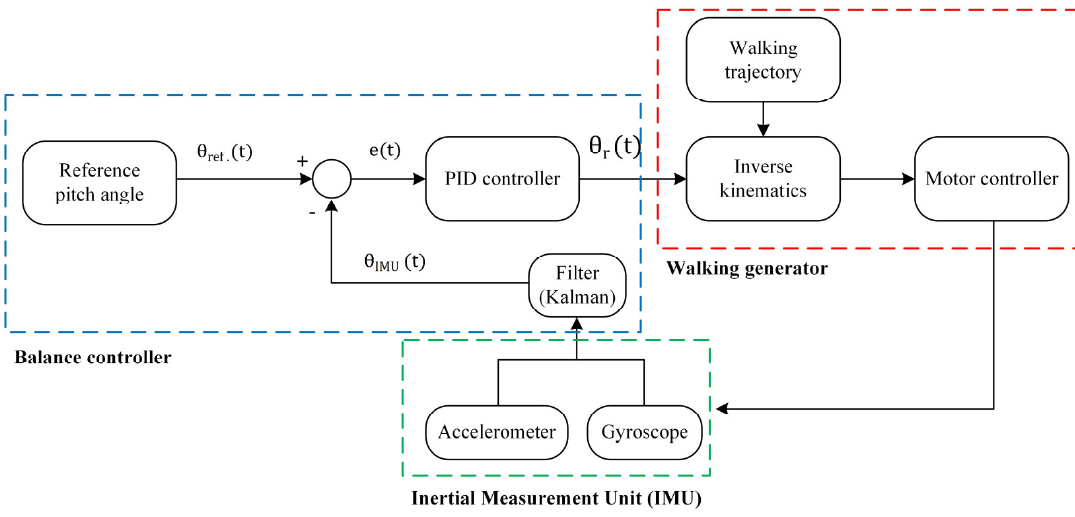
Figure 15. Block diagram of body stabilization control during walking.